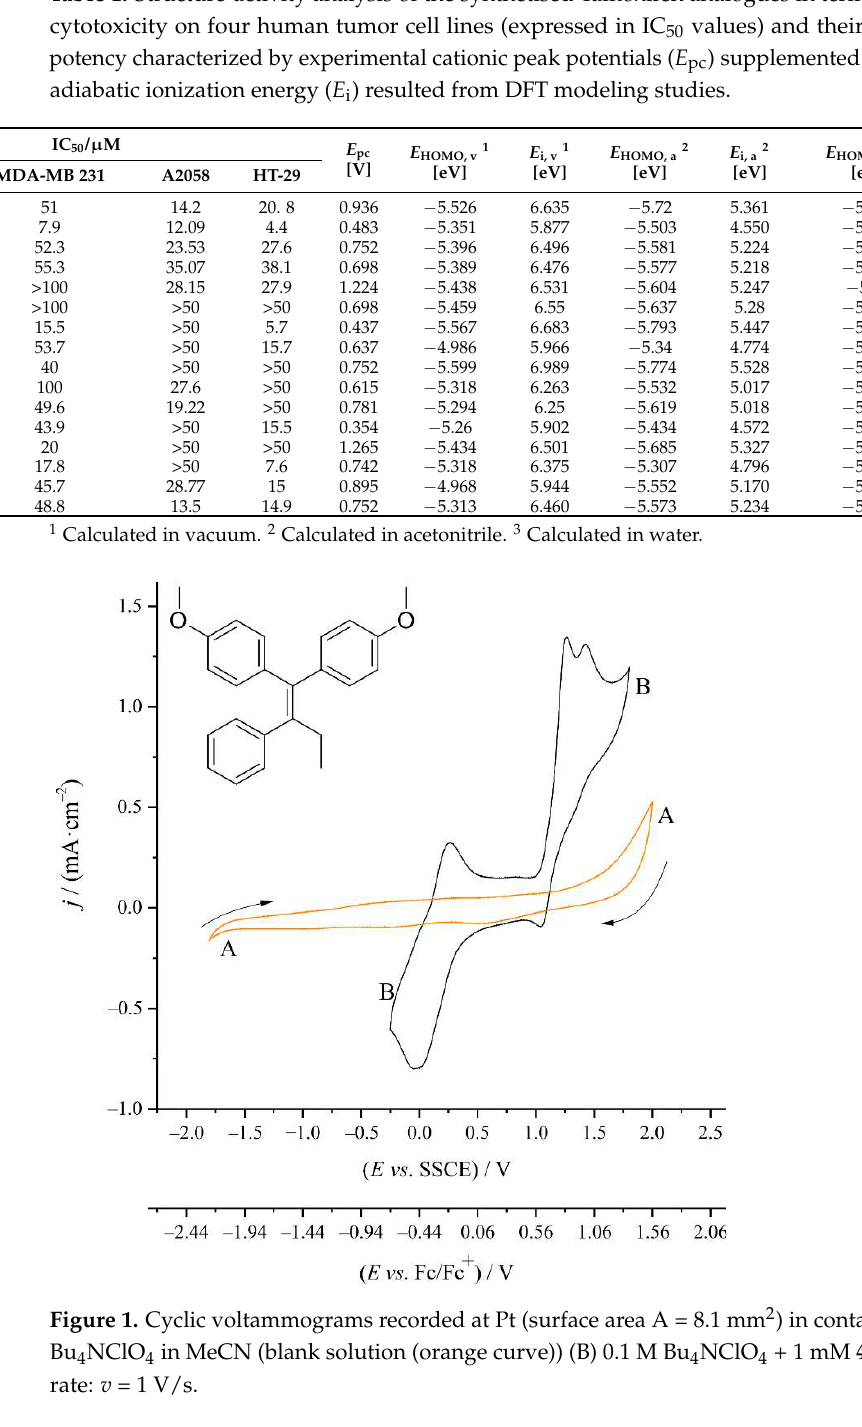
Figure 2. Cyclic voltammograms recorded at Pt (surface area A = 8.1 mm 2 ) in contact with (A) 0.1 M Bu 4 NClO 4 in MeCN (blank solution (orange curve)) (B) 0.1 M Bu 4 NClO 4 + 1 mM 43 in MeCN. Scan rate: v = 1 V/s .